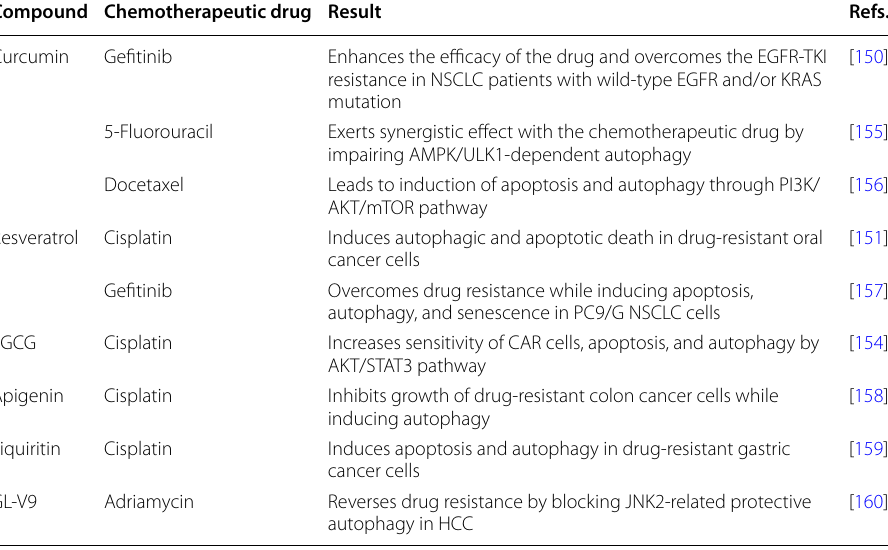
Table 1 Polyphenols that exert an effect on autophagy to increase the sensitivity of tumor cells to chemotherapeutic drugs Compound Chemotherapeutic drug Result